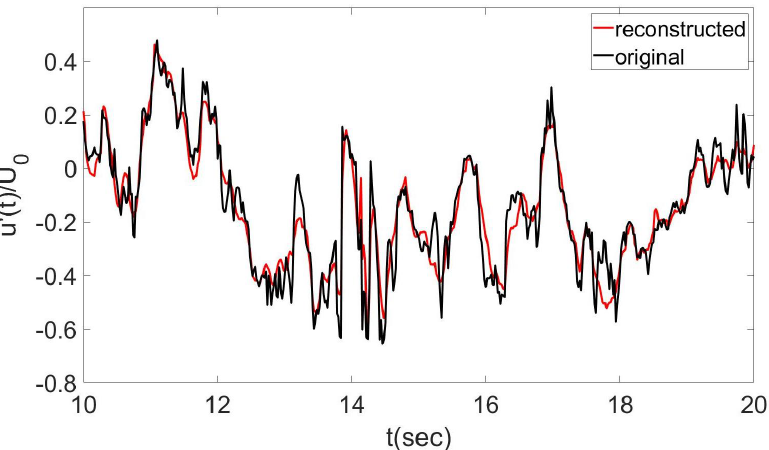
Figure 19. The relative energy content of the first twenty POD modes within ( a ) the individual measurement volumes over the channel bank, ( b ) vertical planes aligned with the flow and located beyond the retaining wall in the spanwise direction, and ( c ) vertical planes perpendicular to the main flow direction within the main channel.